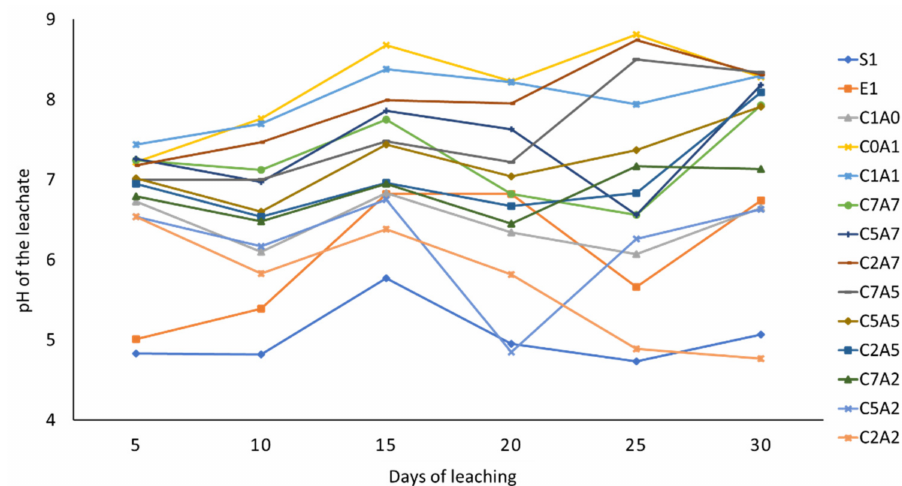
Figure 2. Treatments on pH of leachate over thirty days of leaching, where S1: soil only; E1: soil with ERP only; C1: 100% charcoal; C0: 0% charcoal; C7: 75% charcoal; C5: 50% charcoal; C2: 25% charcoal; A1: 100% sago bark ash; A0: 0% sago bark ash; A7: 75% sago bark ash; A5: 50% sago bark ash; A2: 25% sago bark ash.